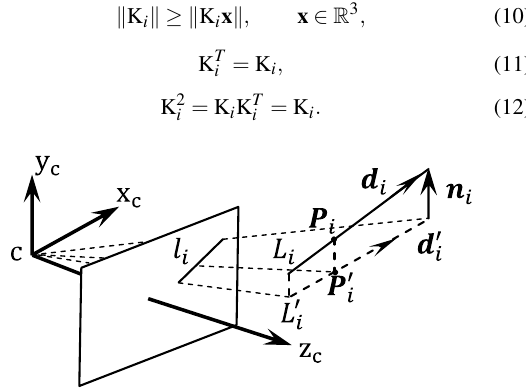
Figure 2: Object-Space error of line